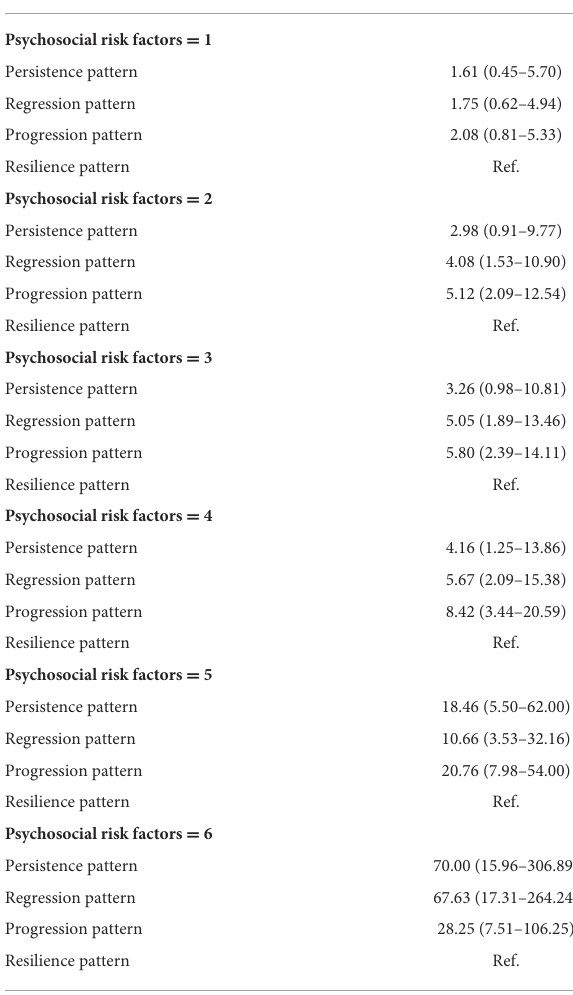
TABLE 4 Dose-response analysis between the number of identified baseline psychosocial risk factors and overall mental burden changing